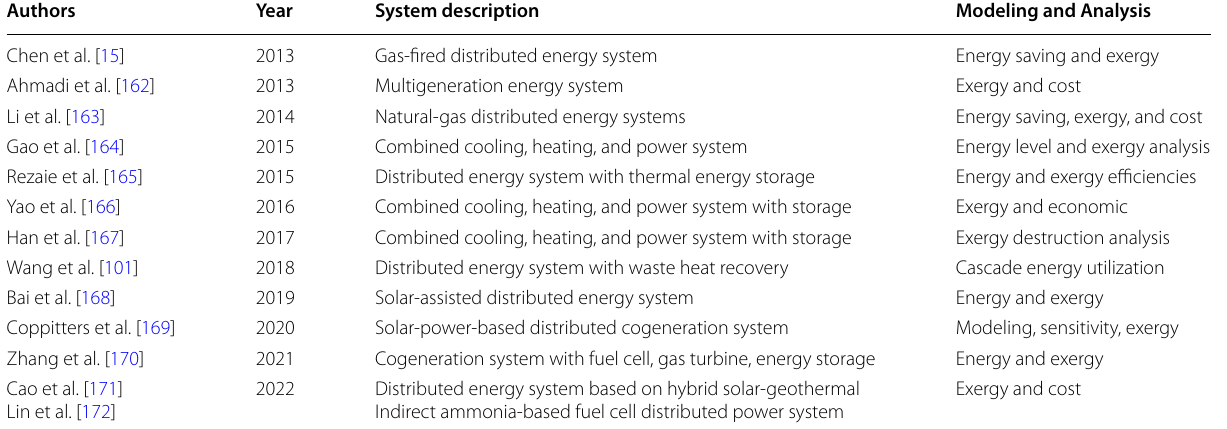
Table 3 Literatures on thermodynamic analysis method for distributed energy